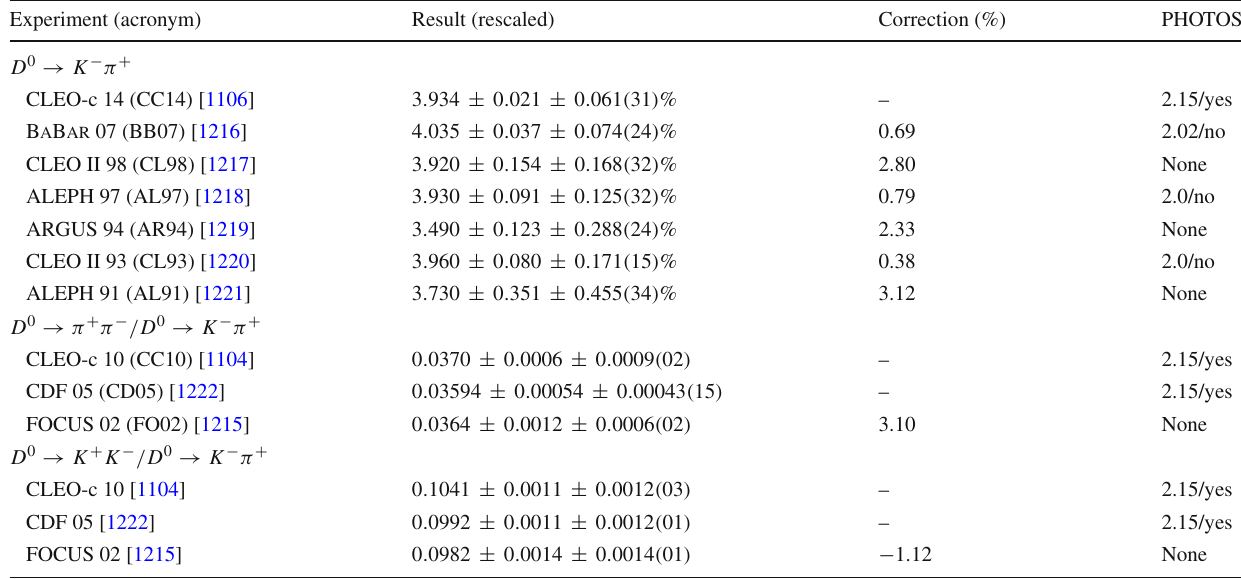
Table 286 The experimental measurements relating to B ( D 0 → to the common version and configuration of PHOTOS. The uncertain- ties are statistical and total systematic, with the FSR-related systematic